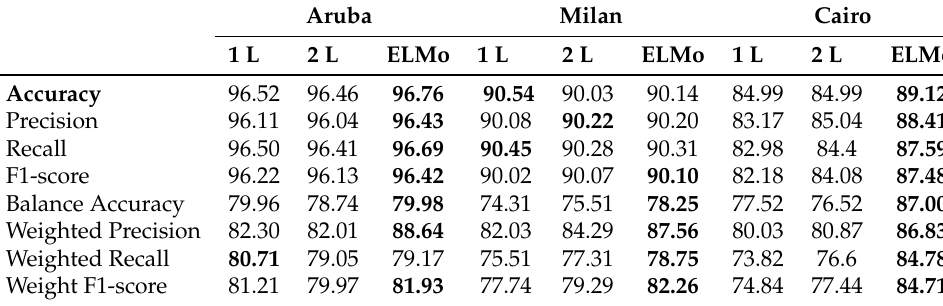
Table 8. Comparison with two layers of